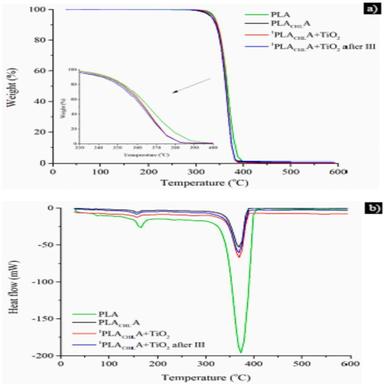
a) TGA thermograms and b) DSC thermograms of PLA, PLACHLA, 1 PLACHLA + TiO2, 1 PLACHLA + TiO2 after three cycles of illumination.